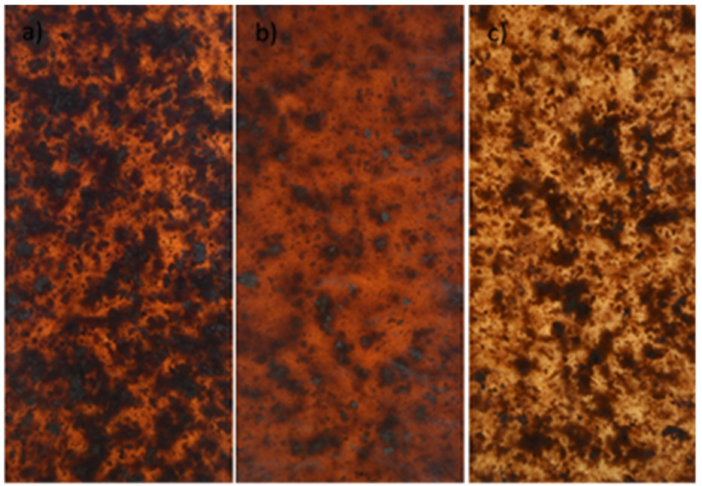
Figure 1. Examples of composite tiles with wood flour Lignocel C120 (PP/Lignocel